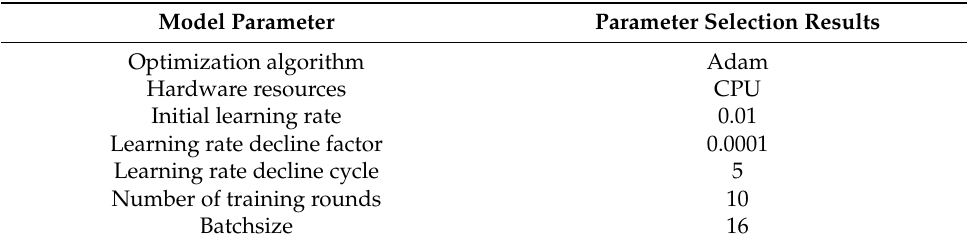
Table 4. LSTM model training parameters.